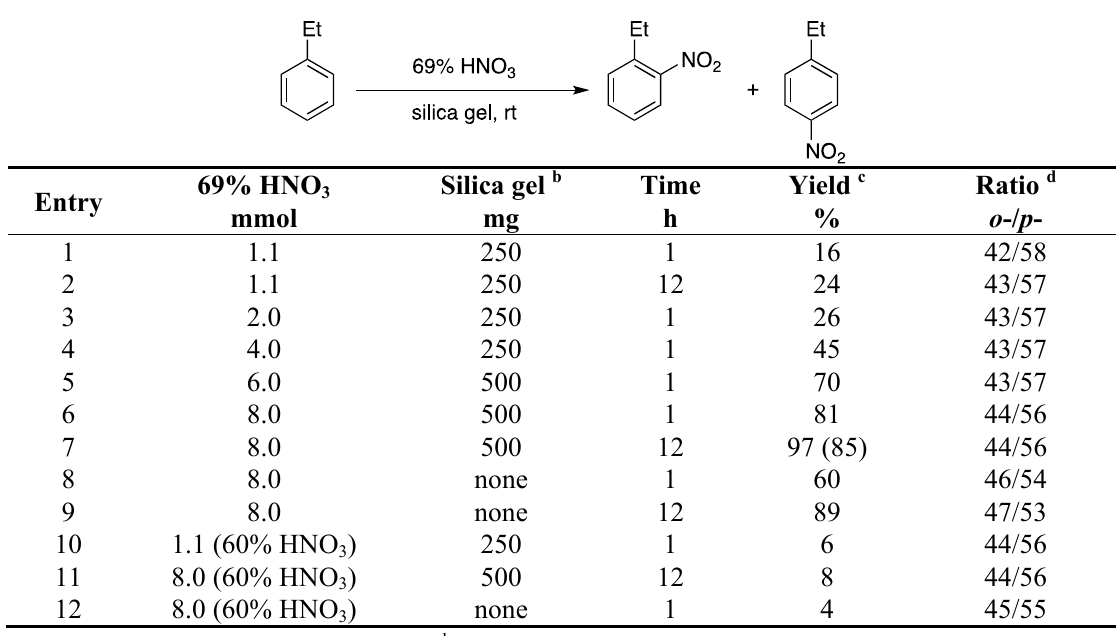
Table 1. The nitration of ethylbenzene with nitric acid on silica gel a